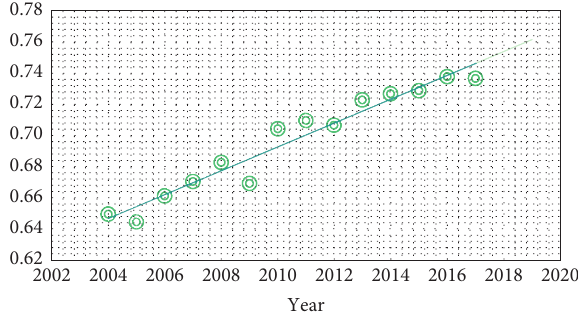
Figure 4: Trends of CCD average in China from 2004 to